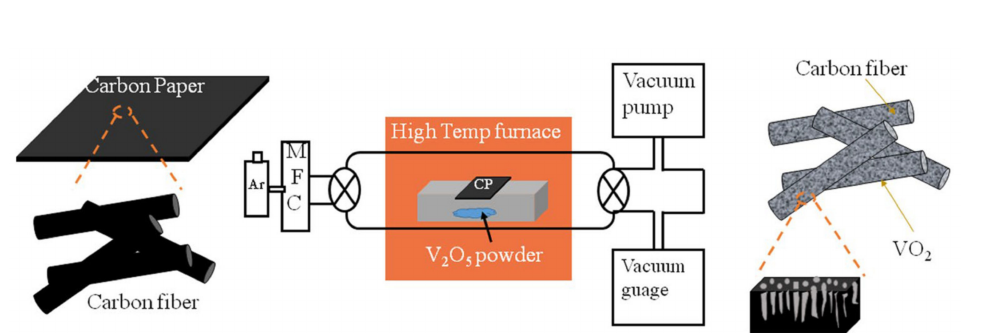
Figure 14. Schematic of chemical vapor depositing VO 2 on carbon fibers. Reproduced under the terms and conditions of the liberal Creative Commons Attribution 4.0 International (CC BY) license from [108]. Published by Springer Nature. Copyright © 2019 The